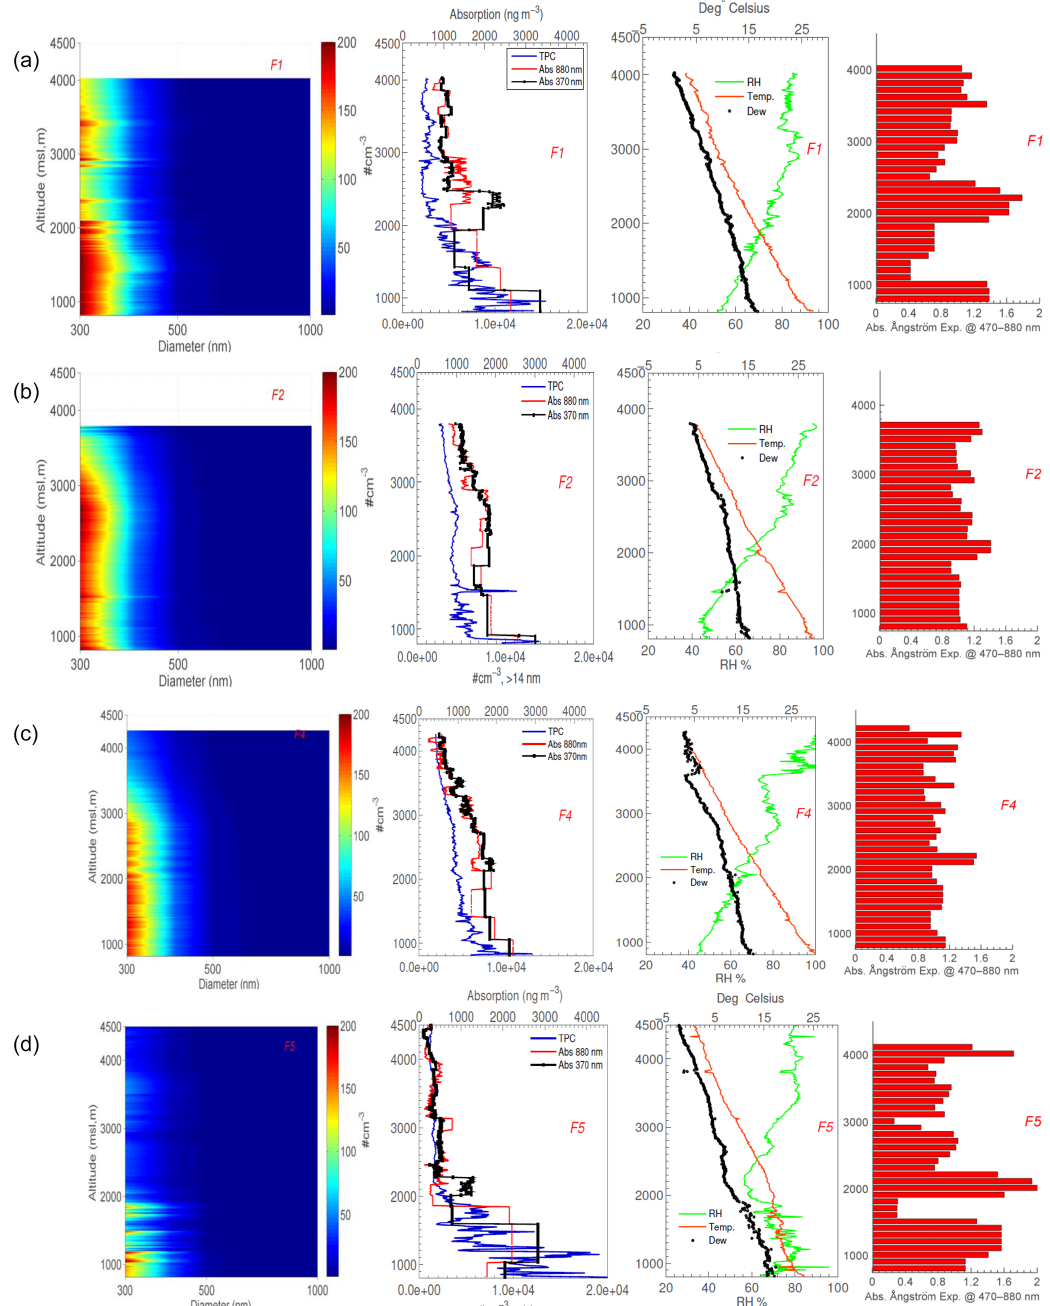
Figure 4. Vertical profiles of aerosol species and meteorological parameters during the 5–7 May 2016 test flights in the Pokhara Valley using the IKARUS microlight aircraft. The subplot in each row is arranged by (i) size distribution measured by the GRIMM OPS 1.108 (0.3–20µm), limited to 1µm in the figure, (ii) total particle number concentration (also indicated as TPC, D p > 14nm) measured by the CPC 3760, along with absorbing aerosol mass density at 370 and 880nm (iii) temperature (red line, in ◦ C) and dew point (black dots, in ◦ C) and relative humidity (or RH%), and (iv) calculated absorption Ångstrom exponent averaged for every 100m elevation band. For the size distribution plot, the x axis represents the optical diameter of the aerosol (nm) and the color bar represents the concentration (10 x in no.cm − 3 ). Of the five test flights, only F1–2 and F4–5 are shown here (a–d) ; F3 is in the Supplement (Fig. S10). Number size distribution data from Flight F3 are not available due to the failure of Grimm’s pump during flight initiation. In each subplot, the y axis is the altitude above the mean sea level (in m). The origin of the y axis is at